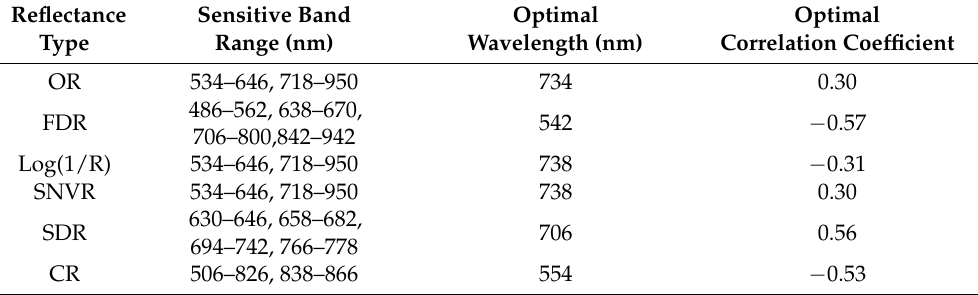
Table 3. Statistics of bands sensitive to potato PNC and with single-band reflectance.